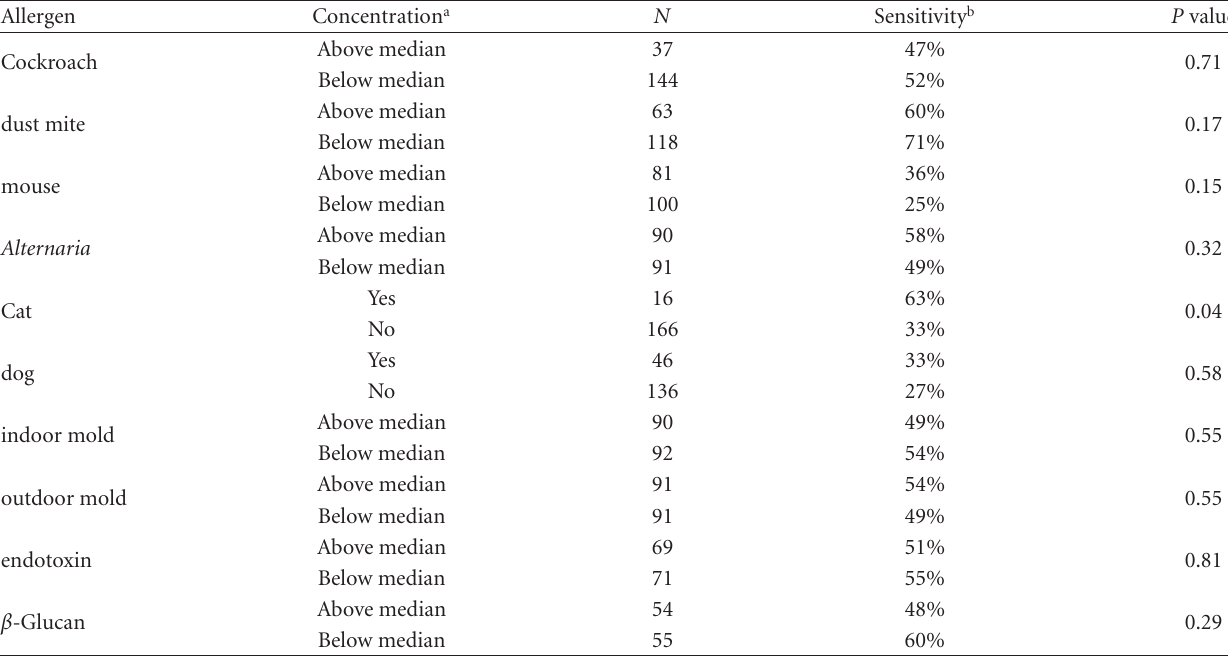
Table 2: Relationship of environmental allergen concentrations to allergen